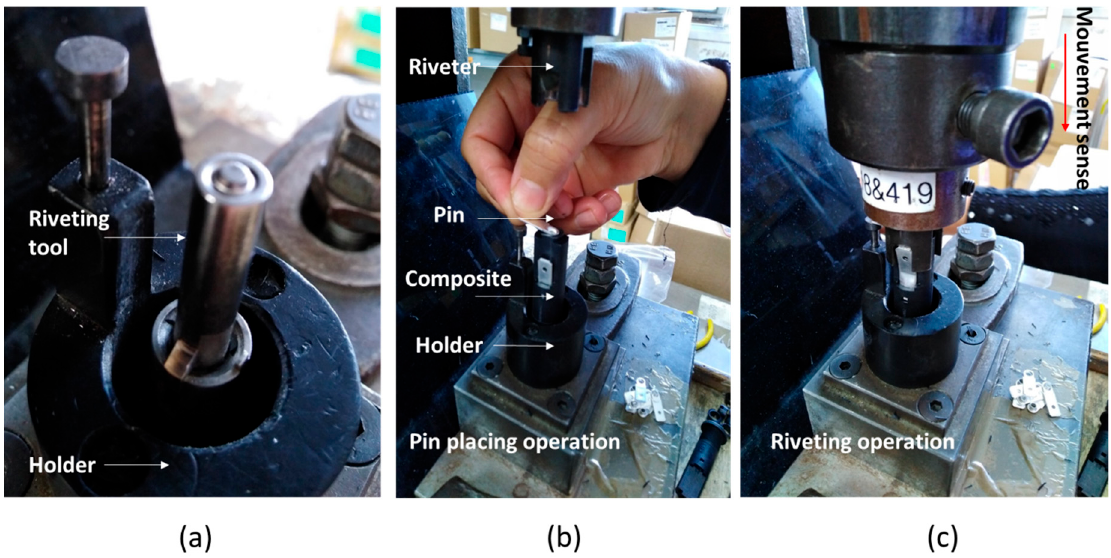
Figure 4. ( a ) Riveting bench; ( b ) Pin placing operation; ( c ) Pin riveting operation of composite.